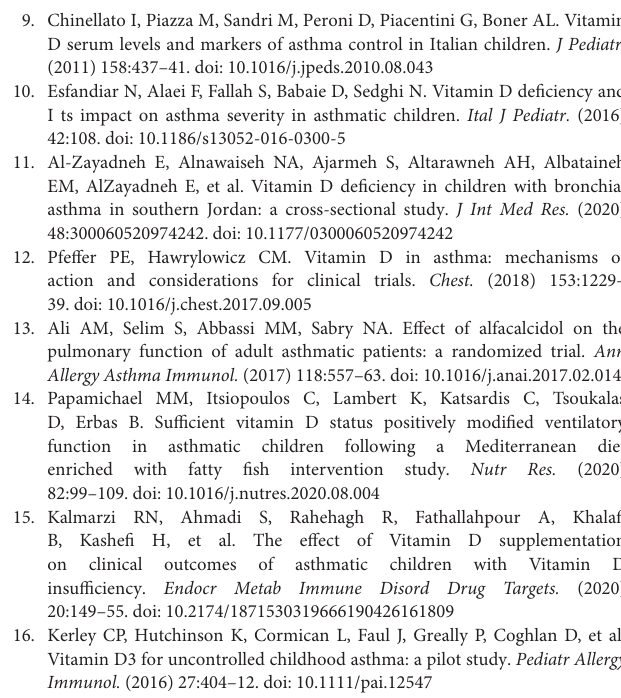
Supplementary Figure S1 | Risk of bias graph for included studies. Supplementary Figure S2 | Forest plots RR of serious adverse events associated with vitamin D versus placebo. Supplementary Figure S3 | Subgroup analysis of CACT scores, asthma exacerbation and FEV1%. Supplementary Figure S4 | Meta-based influence analyses for vitamin D levels (A) and FEV1% (B) . Supplementary Figure S5 | Egger’s and Begg’s tests for comparisons of vitamin D levels (A) and FEV1% (B)